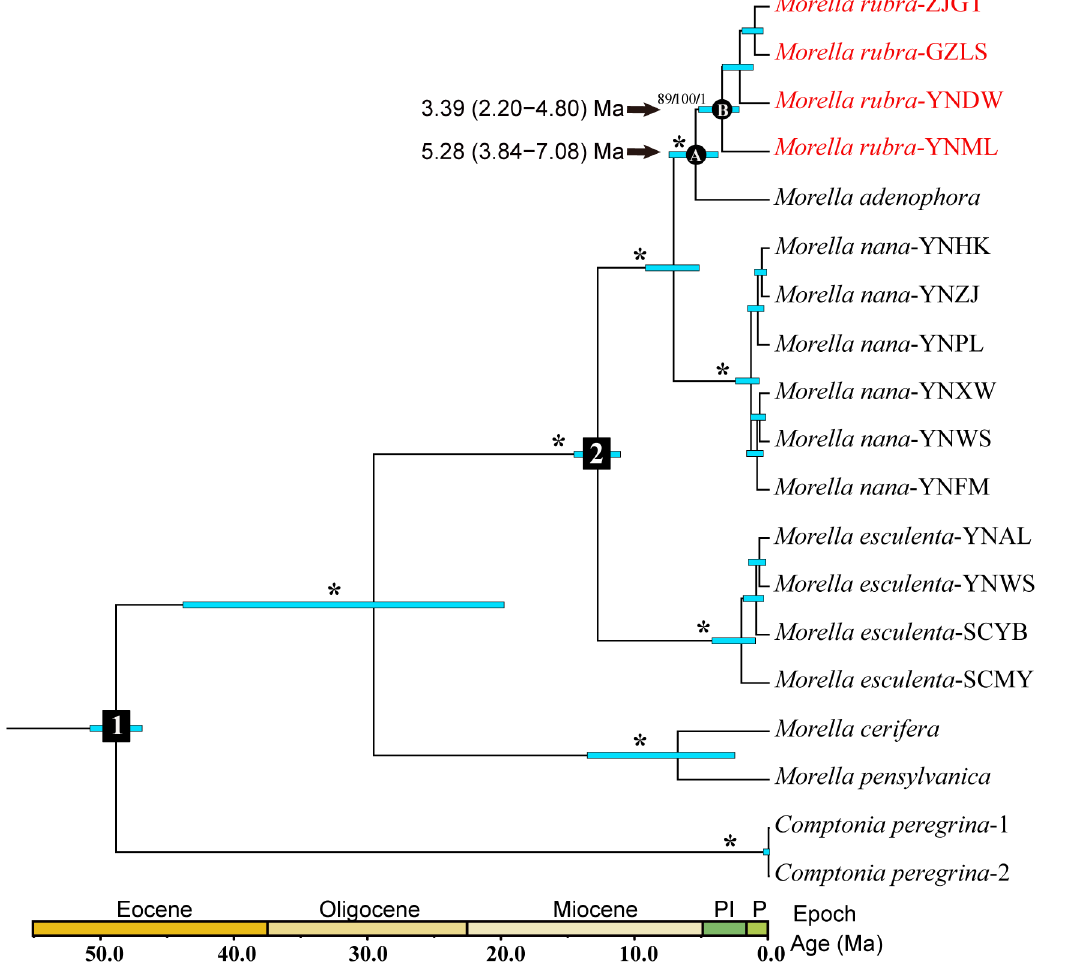
Fig 2. Bayesian phylogeny and divergence time estimation of Morella . Node1 and node2 represent two calibration points described in methods above. Blue bars indicate the 95% highest posterior density (HPD) credibility intervals for node ages (Ma). Asterisk indicates that maximum-parsimony bootstrap/ maximum-likelihood bootstrap/Bayesian inference posterior probability equal to